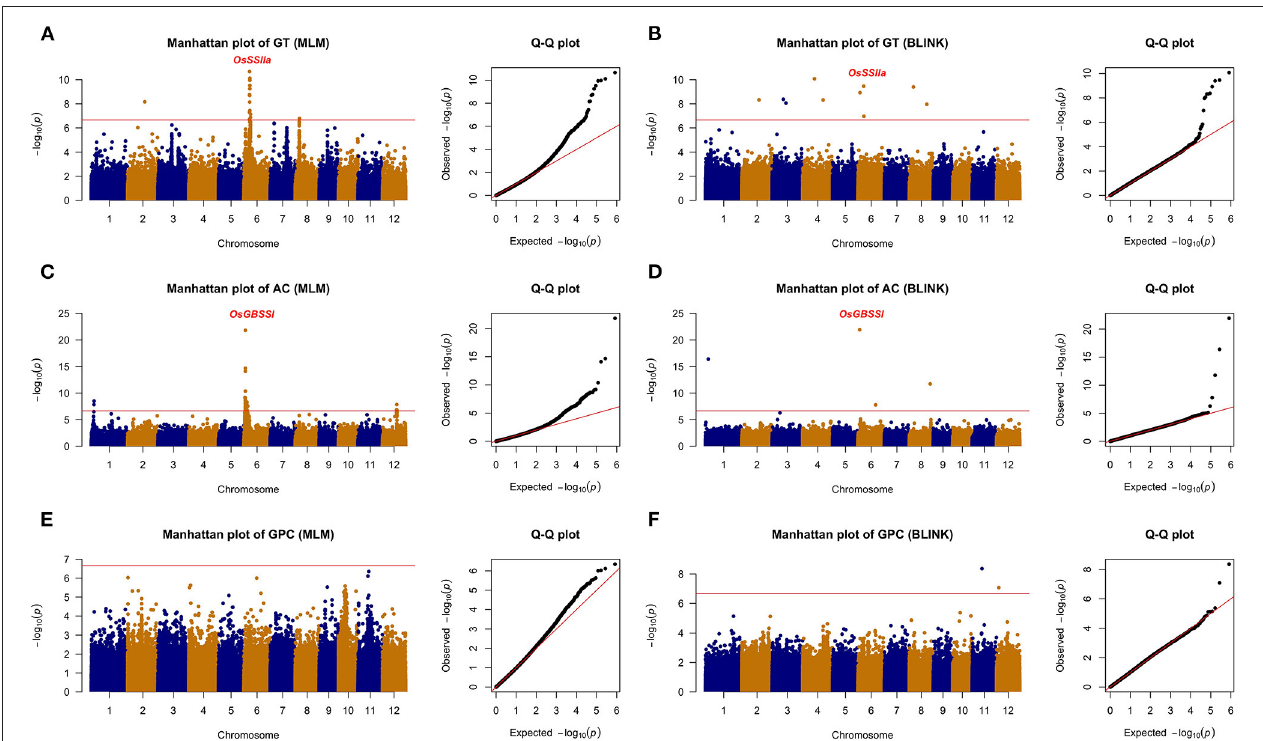
FIGURE 4 | The genome-wide association analysis of grain quality with MLM and BLINK methods. (A) GT with MLM, (B) GT with BLINK, (C) AC with MLM, (D) AC with BLINK, (E) GPC with MLM, and (F) GPC with BLINK. The horizontal red line indicated the significance thresholds at –log10( p ) =